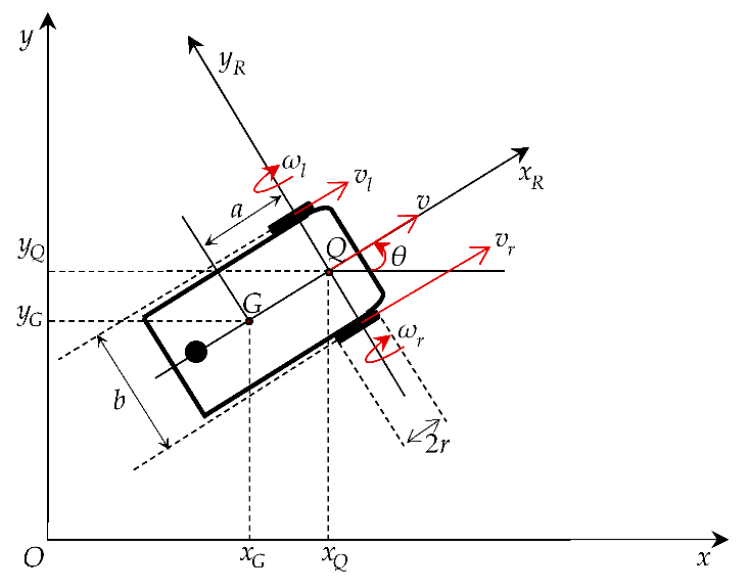
Figure 3. Geometry of a differential drive wheeled mobile robot.